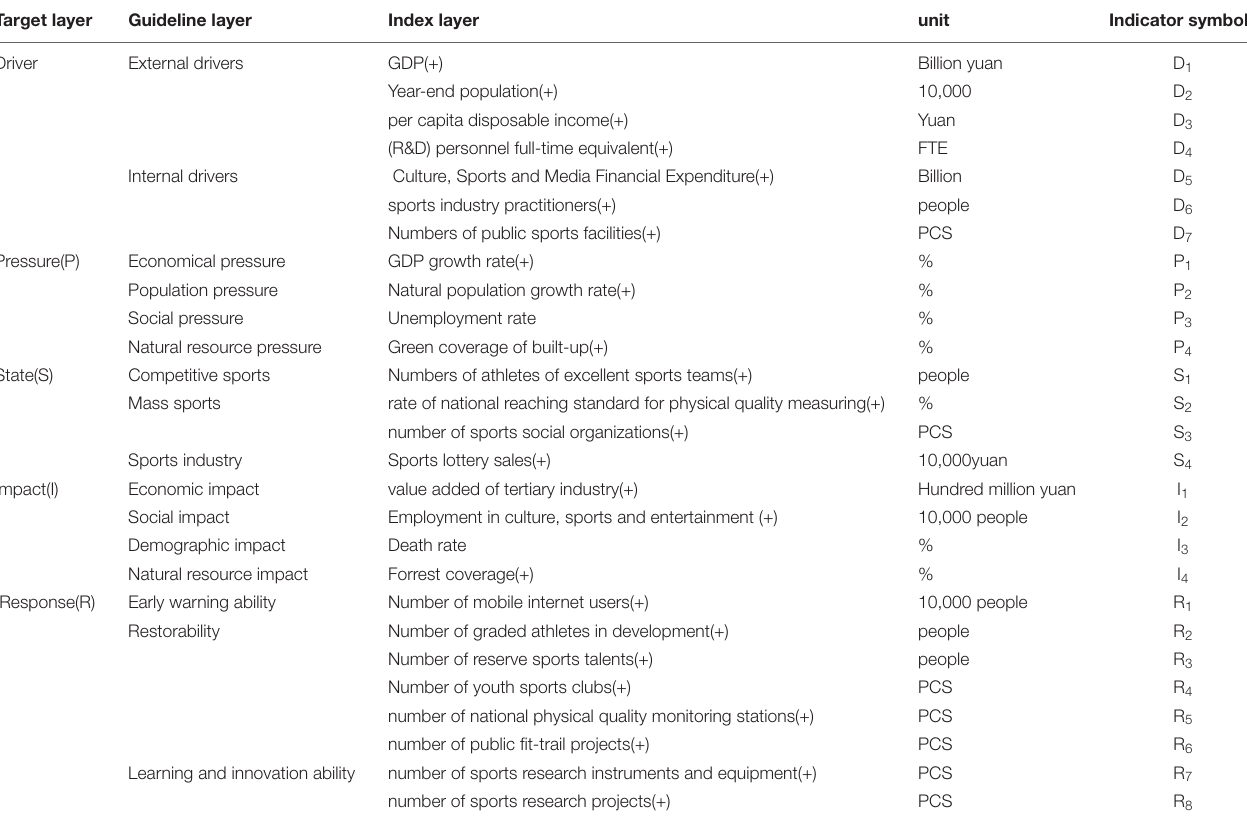
TABLE 1 | Resilience evaluation indexes system for sports regional development in